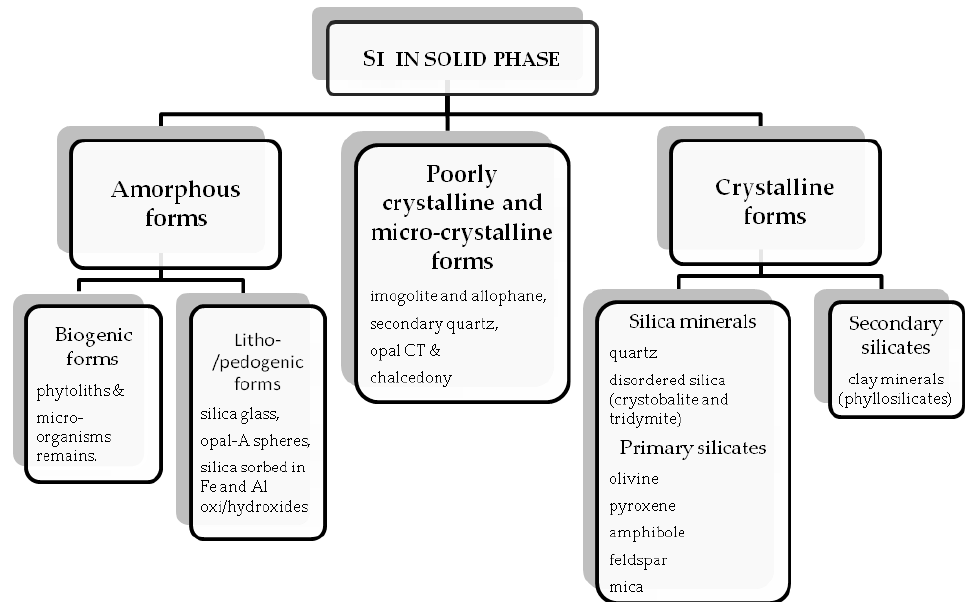
Fig. 2. Classification of solid Si compounds in the soil (modified from Sauer et al., 2006).